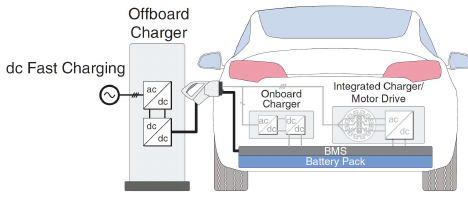
Figure 1. On-board charger versus off-board charging system.